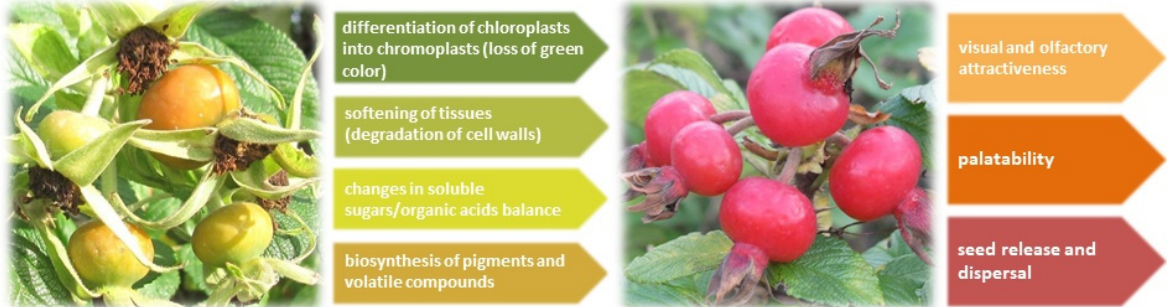
Figure 1. The main processes involved in ripening of edible fruits illustrated by the example of rugosa rose ( Rosa rugosa Thunb.) accessory fruits referred to as hips.